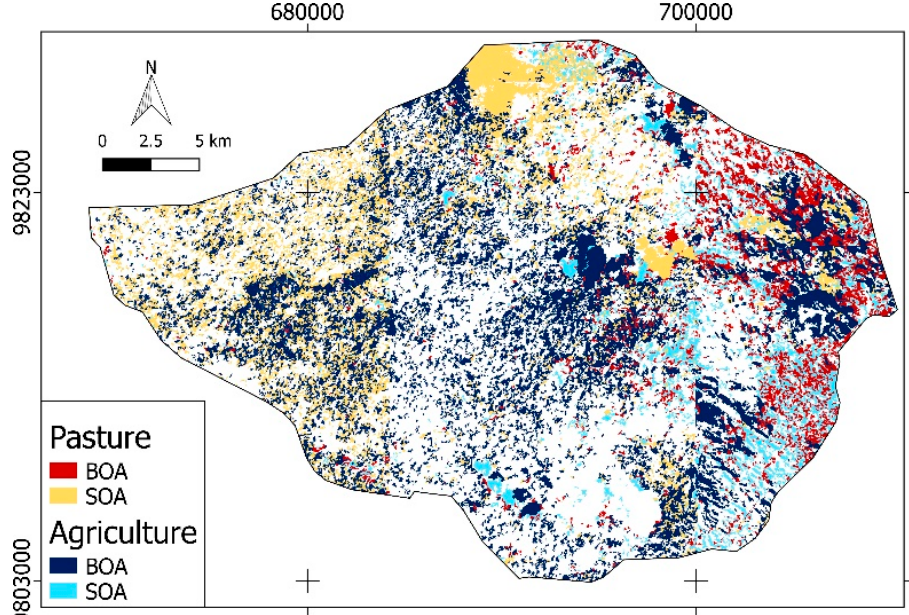
Figure 11. Map representing agriculture and pasture production systems in Katoyi (Reference Frame: WGS84/UTM35S). Table 8. Agriculture and pasture production system areas in Katoyi according to the LU map pro- duced.